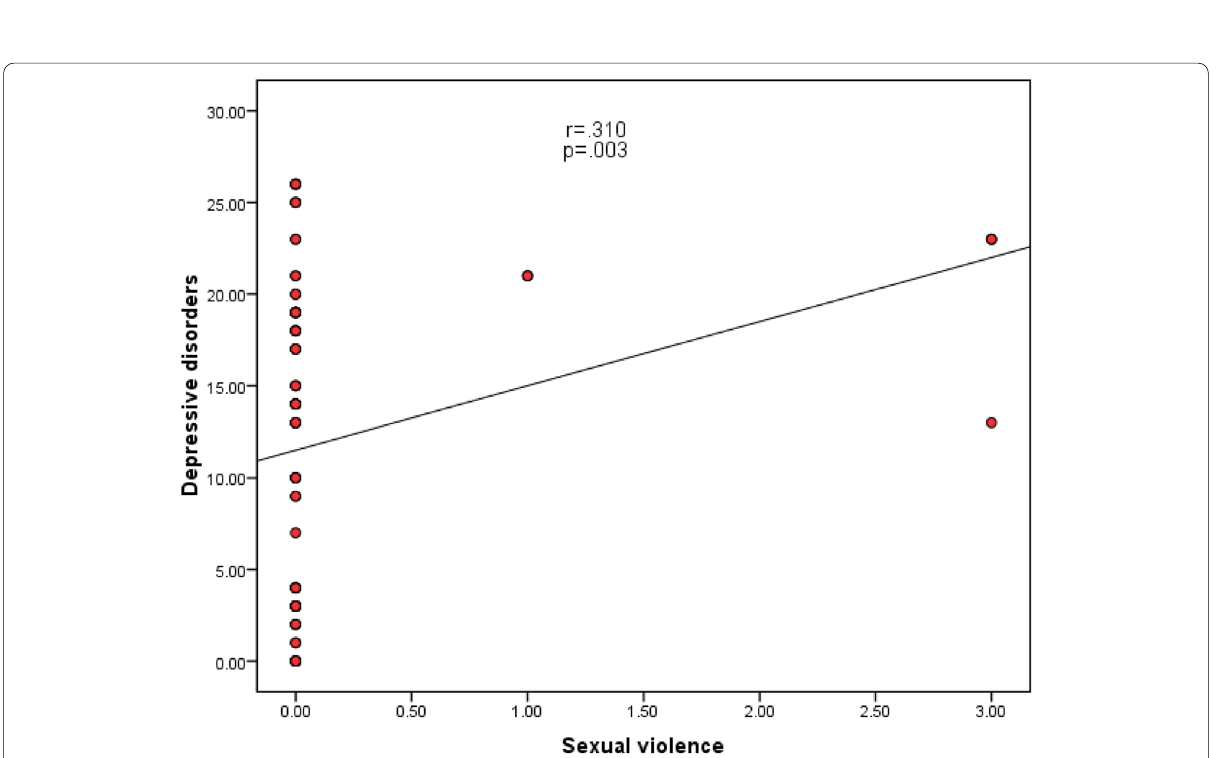
Fig. 8 Scatter diagram showing correlation between sexual violence and depressive